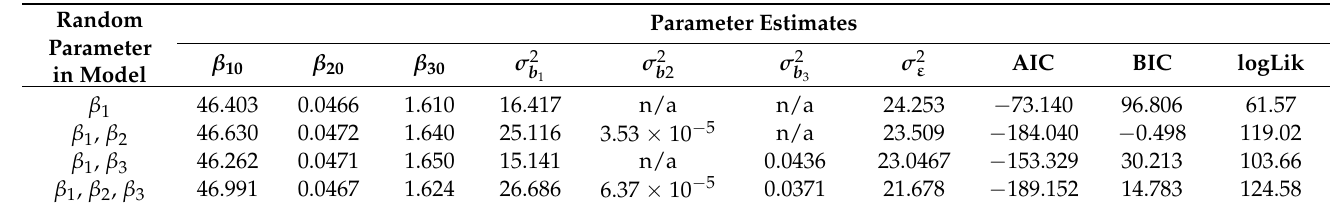
Table 1. Parameter estimates (fixed effect parameters: β 10 , β 20 and β 30 ; estimated variance